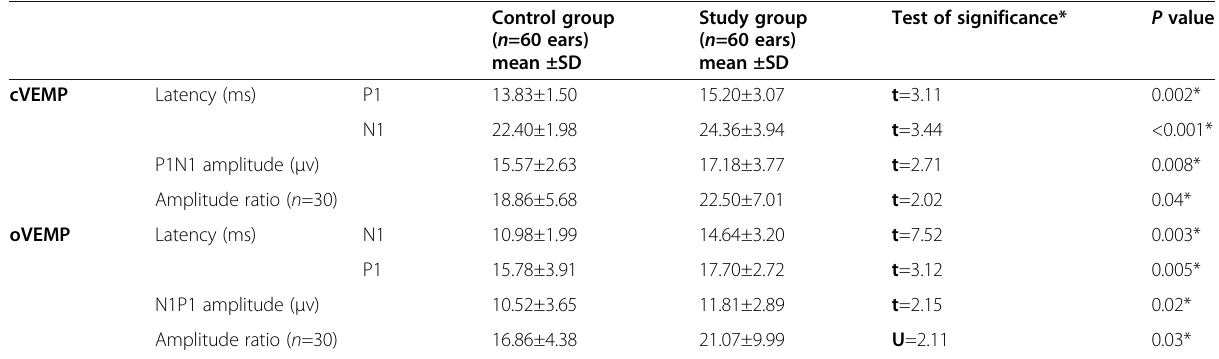
Table 2 The peak latencies and amplitudes of o and c